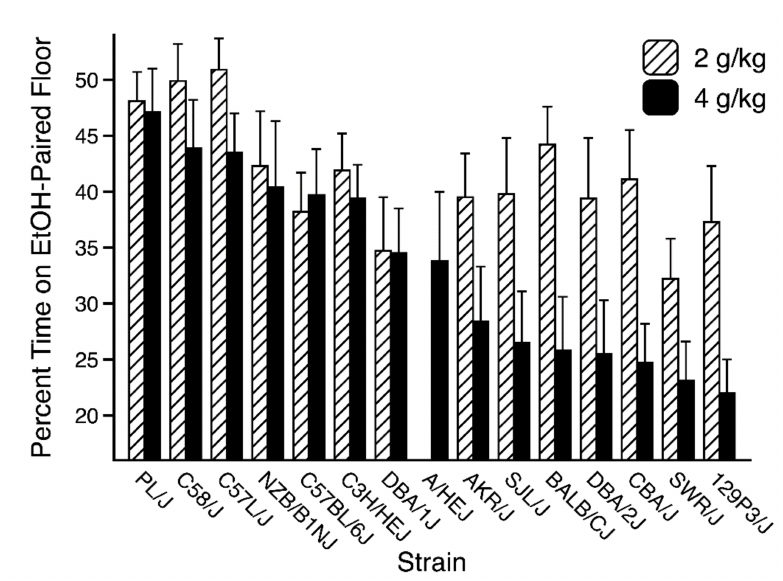
Figure 4. Conditioned Place Aversion Test. Mean percent time ( + SEM) spent on the ethanol-paired floor (collapsed across conditioning subgroup) by each strain at each ethanol dose. Each bar depicts 9–13 mice (0 g / kg groups) or 18–26 mice (2 and 4 g / kg